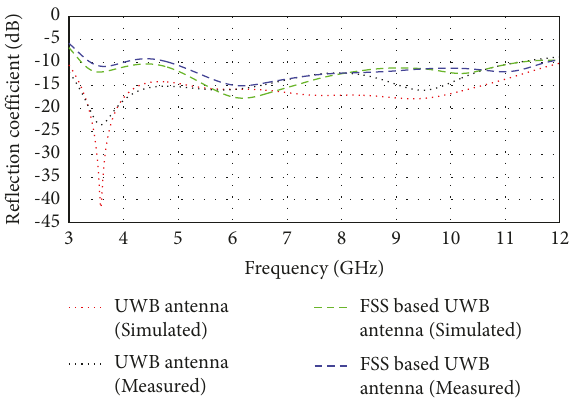
Figure 9: Tested and simulated reflection coefficient ( S 11) of antenna with and without